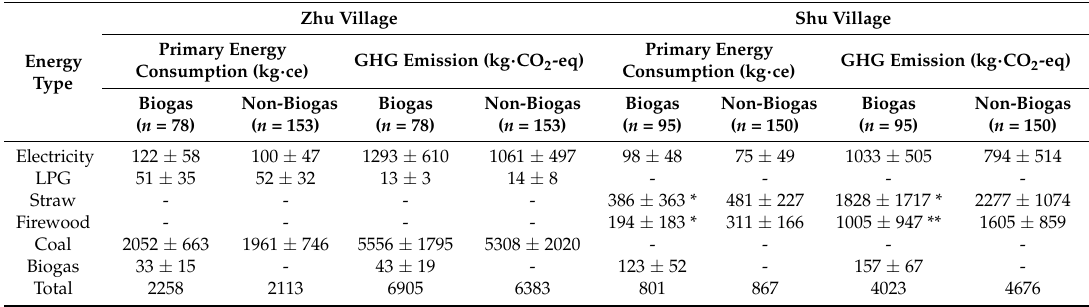
Table 4. Per household energy consumption and associated GHG emissions in the two study villages, expressed per household over a 12-month period.